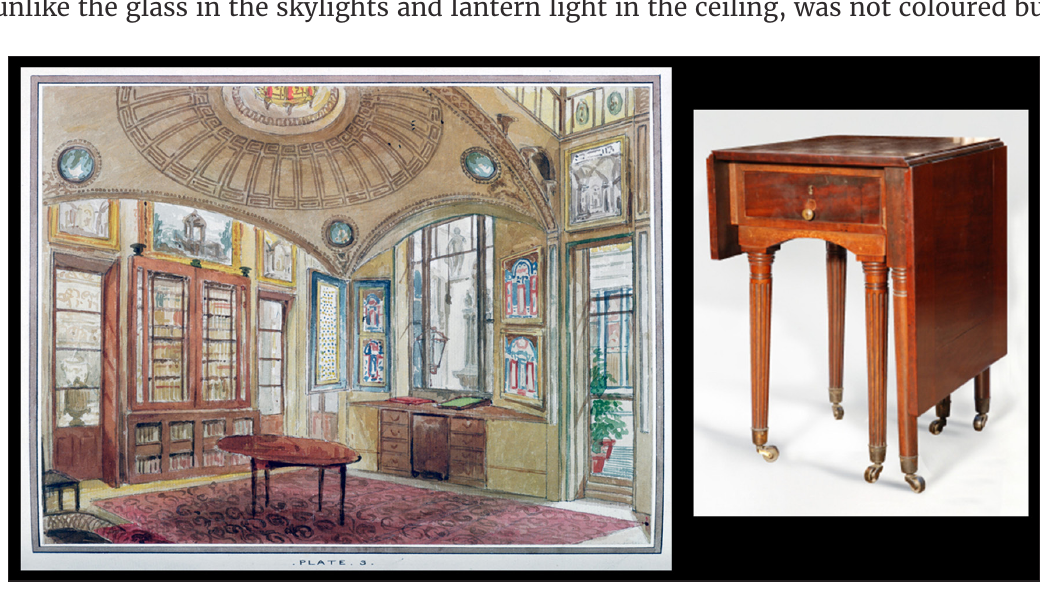
Fig. 4 : View of the breakfast room, preparatory drawing for plate 3 of Soane’s 1830 Description of the House and Museum , c. 1829, watercolour, Sir John Soane’s Museum SM Vol.